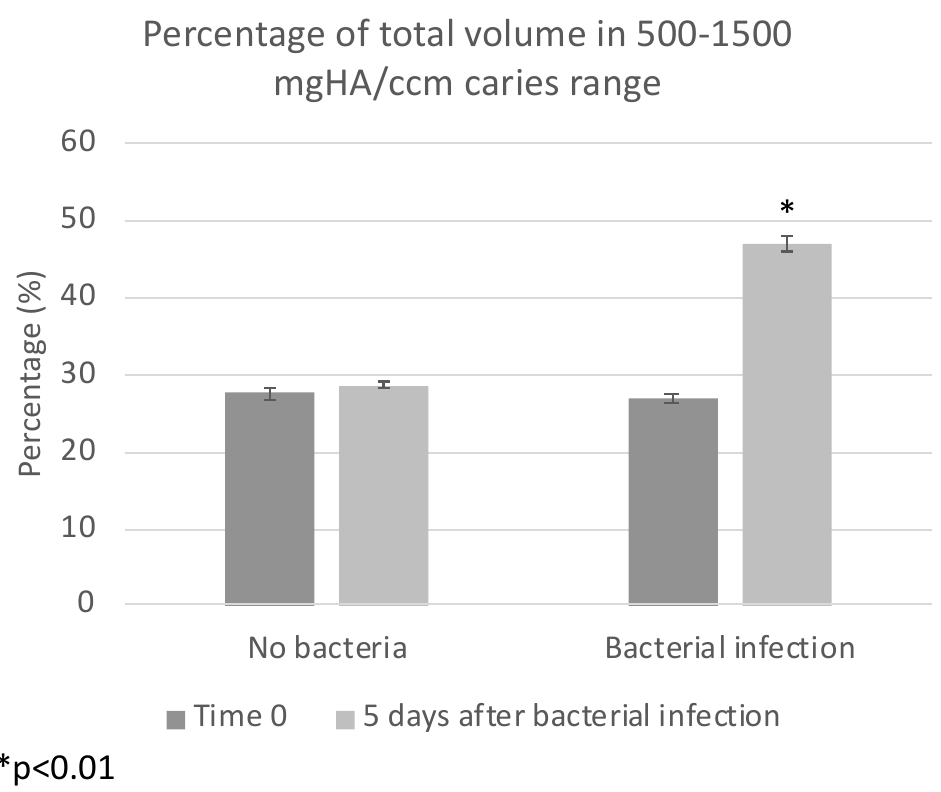
Figure 5. Quantification of demineralization. µCT analysis comparison of volumetric percentage in the pulp and caries representing range (500–1500 mgHA/ccm) before (dark gray) and after (light gray) the experimental period. A significant increase ( p = 0.000069) in the caries representing range was observed in the S. mutans UA159 bacterial-infected group.